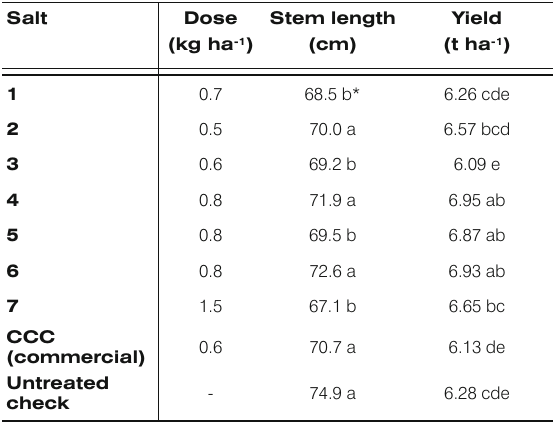
Table 4. (cid:55)(cid:75)(cid:72)(cid:3)(cid:76)(cid:81)(cid:288)(cid:88)(cid:72)(cid:81)(cid:70)(cid:72)(cid:3)(cid:82)(cid:73)(cid:3)(cid:86)(cid:68)(cid:79)(cid:87)(cid:86)(cid:3)(cid:90)(cid:76)(cid:87)(cid:75)(cid:3)(cid:21)(cid:16)(cid:70)(cid:75)(cid:79)(cid:82)(cid:85)(cid:82)(cid:72)(cid:87)(cid:75)(cid:92)(cid:79)(cid:87)(cid:85)(cid:76)(cid:80)(cid:72)(cid:87)(cid:75)(cid:92)(cid:79)(cid:68)(cid:80)(cid:80)(cid:82)(cid:81)(cid:76)(cid:88)(cid:80)(cid:3)(cid:3)(cid:3) (cid:3)(cid:3)(cid:3)(cid:3)(cid:3)(cid:3)(cid:3)(cid:3)(cid:3)(cid:3)(cid:3)(cid:3)(cid:3)(cid:3)(cid:3)(cid:3)(cid:3)(cid:3)(cid:3)(cid:3)(cid:3)(cid:3)(cid:3)(cid:3)(cid:70)(cid:68)(cid:87)(cid:76)(cid:82)(cid:81)(cid:3)(cid:82)(cid:81)(cid:3)(cid:87)(cid:75)(cid:72)(cid:3)(cid:86)(cid:87)(cid:72)(cid:80)(cid:86)(cid:3)(cid:79)(cid:72)(cid:81)(cid:74)(cid:87)(cid:75)(cid:3)(cid:68)(cid:81)(cid:71)(cid:3)(cid:92)(cid:76)(cid:72)(cid:79)(cid:71)(cid:3)(cid:82)(cid:73)(cid:3)(cid:87)(cid:75)(cid:72)(cid:3)(cid:90)(cid:76)(cid:81)(cid:87)(cid:72)(cid:85)(cid:3)(cid:90)(cid:75)(cid:72)(cid:68)(cid:87)(cid:17) Salt Dose (kg ha -1